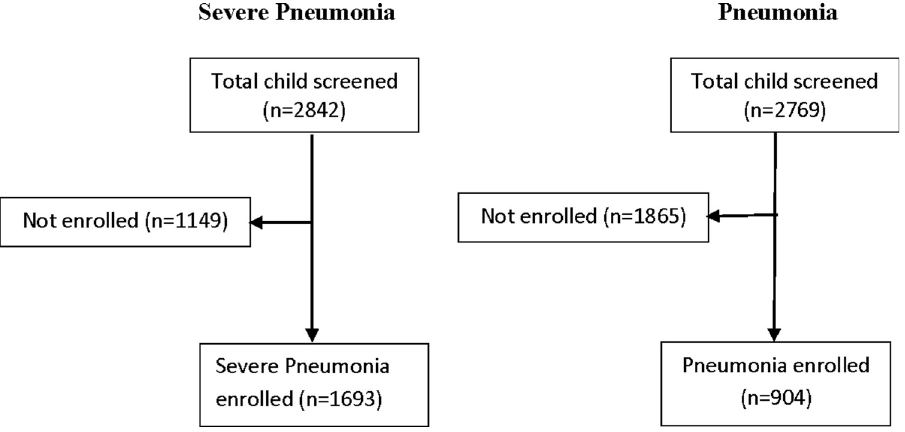
Fig 1. Enrolment profile of the study